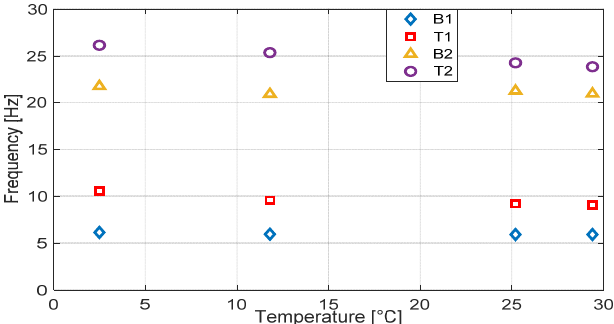
Figure 13. Span S2: evolution of frequency–temperature correlation among different